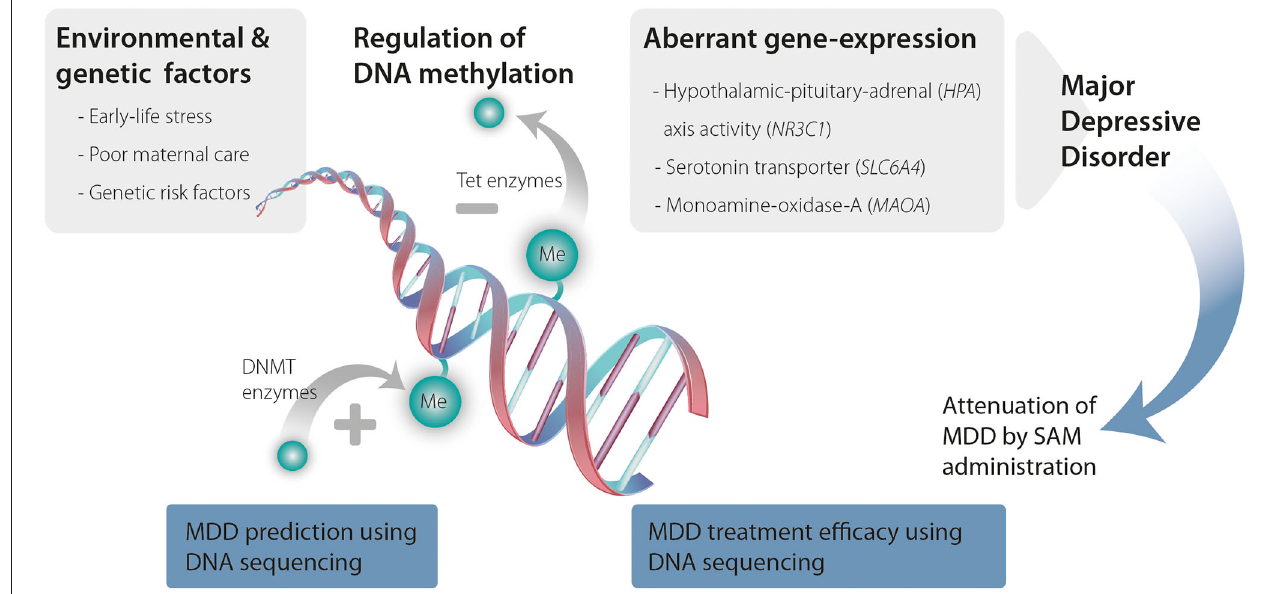
FIGURE 1 | Environmental and genetic risk factors promote changes in DNA methyltransferases (DNMTs) and ten-eleven translocation methylcytosine dioxygenases (TET) activity that increase DNA methylation and demethylation, respectively. Changes in DNA methylation lead to aberrant expression of genes that are associated with MDD ultimately causing MDD. SAM administration can attenuate these changes in DNA methylation. Further, genomic sequencing to detect changes in DNA methylation can serve as a predictive tool for MDD as well as a tool to predict treatment efficacy and